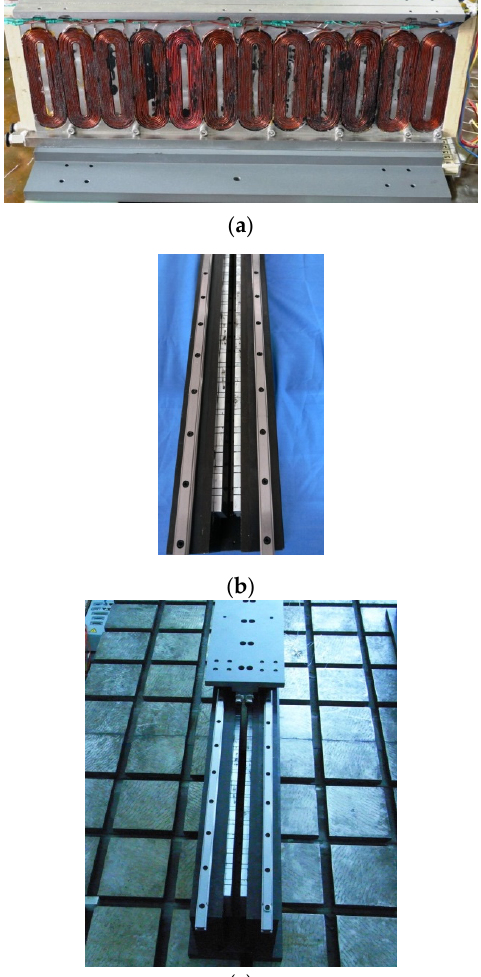
Figure 10. Photos of the prototype. ( a ) The coils and cooling jacket; ( b ) The stator; ( c ) The prototype motor.